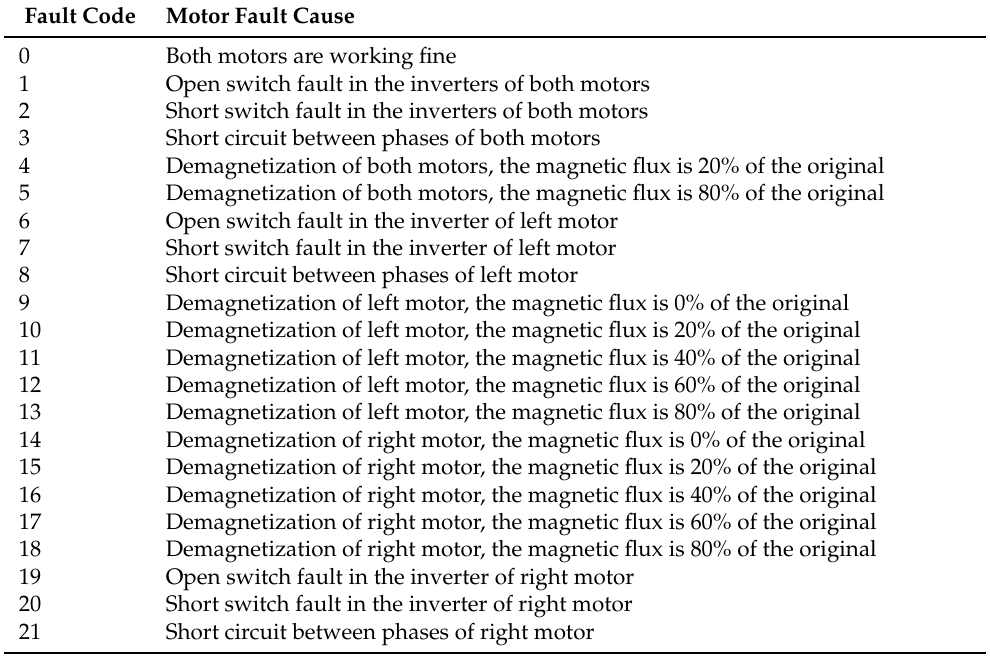
Table A4. Types of motor faults for diagnosis based on